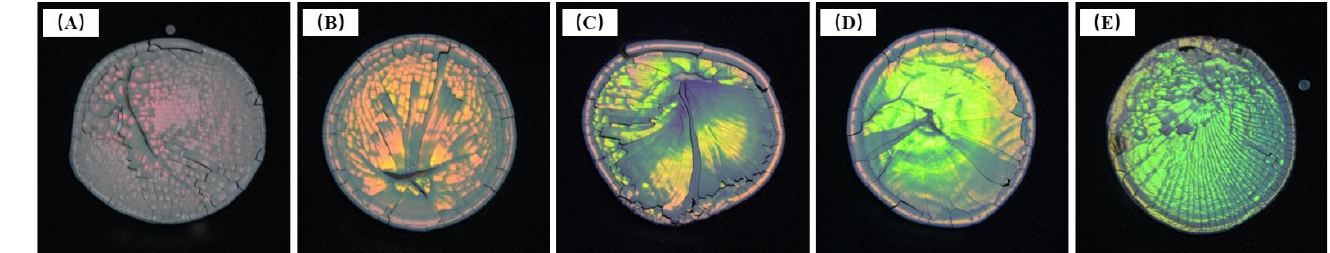
Figure 9. Photos of dried test samples of P(St-AA) colloidal microspheres synthesized with different amounts of SDBS: ( A ) 125 mg; ( B ) 150 mg; ( C ) 175 mg; ( D ) 200 mg; ( E ) 225 mg.